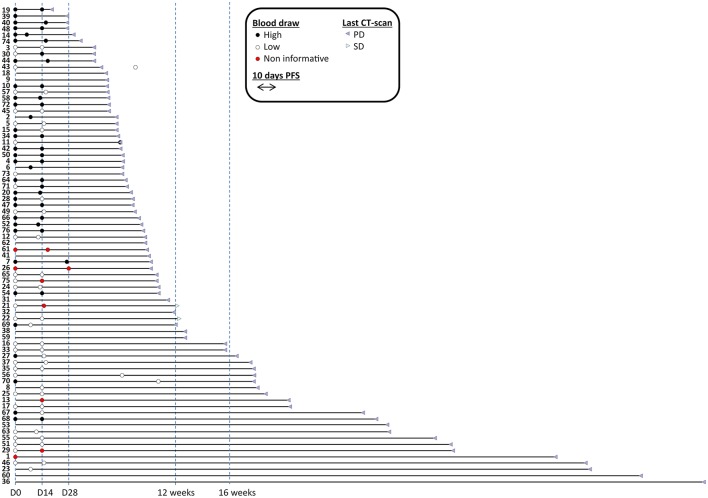
Time to progression of patients enrolled in the study with sample availability and informativeness. Blood draws are represented with filled circles and colored in black when cmDNA/ml was above median, depicted in white when cmDNA/ml was below median; red circles label samples that were not informative (i.e., no positive markers). Patients were sorted by duration of progression free survival. Sixty baseline (among which 57 informative) and 62 under treatment blood draws (among which 56 informative) were available. Fifty seven patients had both types of blood draws available (among which 52 informative in both cases). Two cases were censored for follow-up. Imaging CT-scans are also indicated.